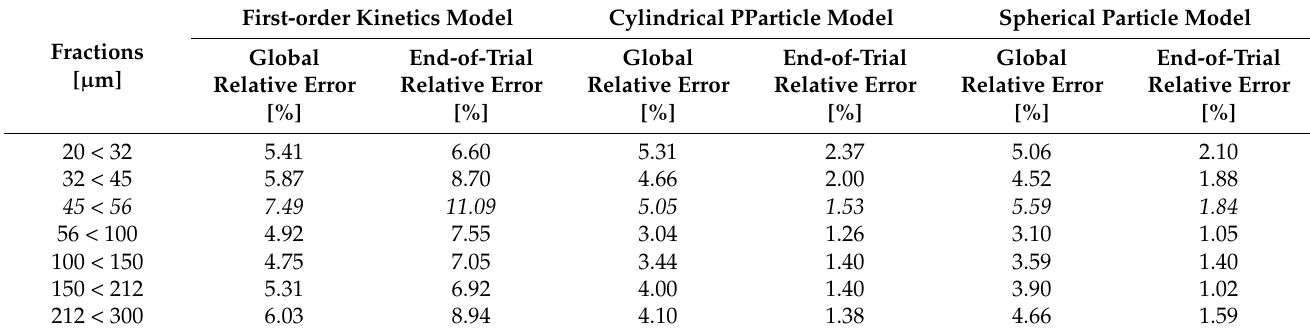
Table 5. Comparison of model performance.